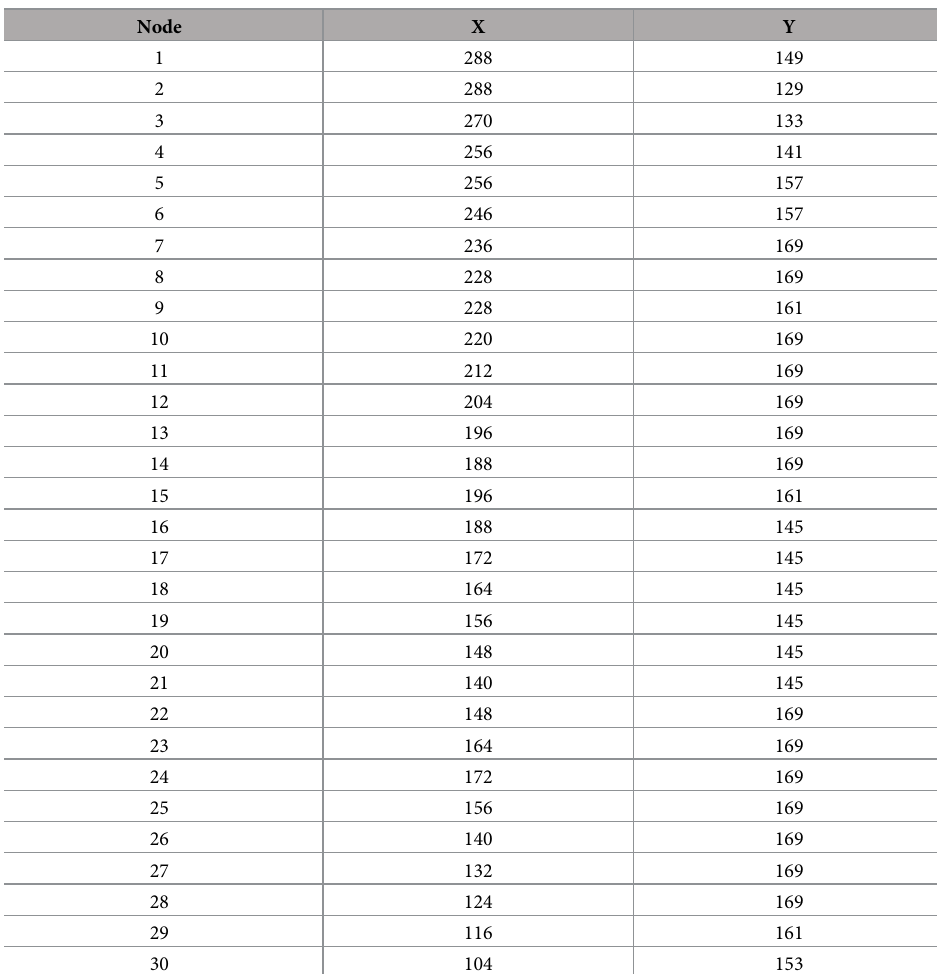
Table 14. Node coordinates with size n =